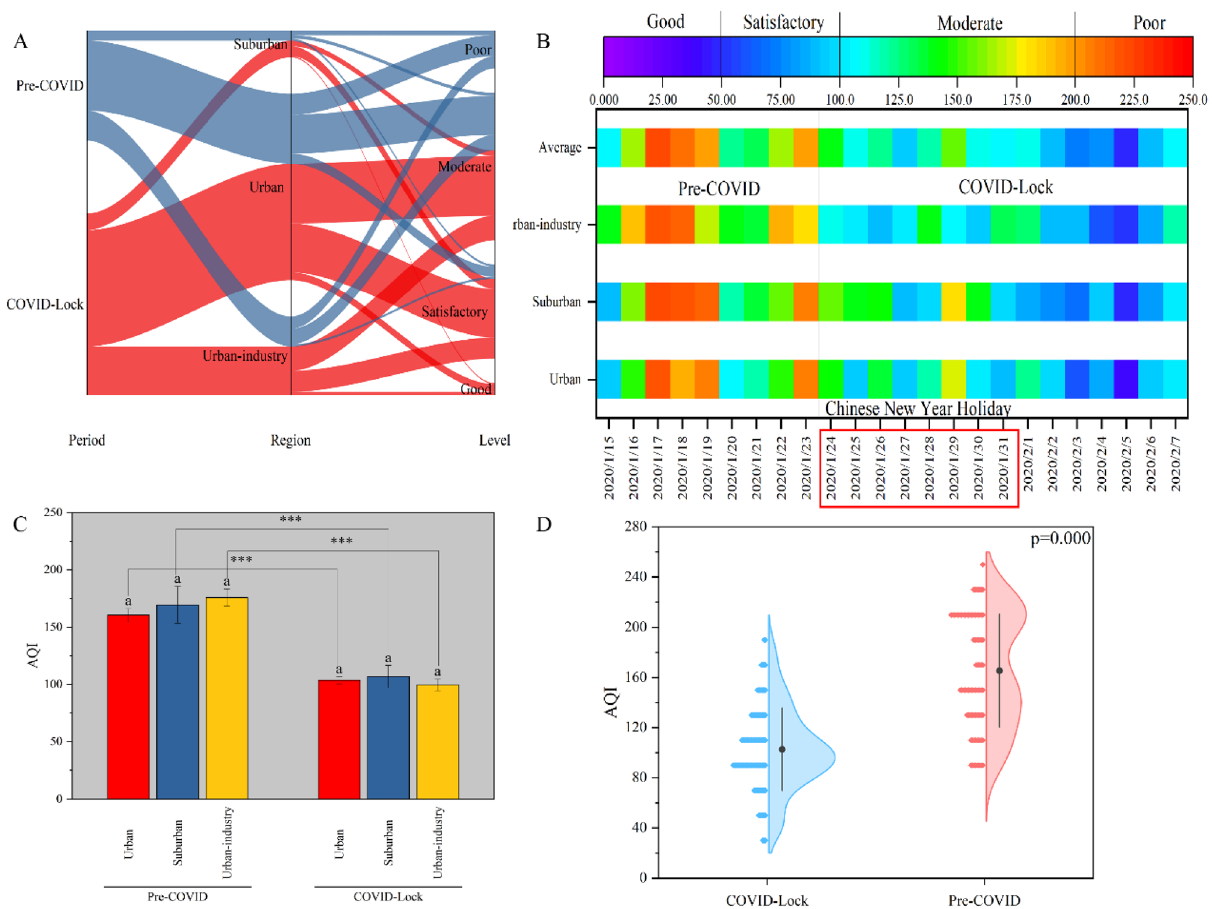
Figure 6. AQI values determined from data collected at the Ji’nan monitoring stations from 15 January to 7 February. ( A ) The parallel plot shows how the AQI level differs among the urban, suburban, urban-industrial areas. ( B ) AQI values determined as time series; ( C ) comparison of the AQI levels among different regions during the pre-COVID and lockdown period; ( D ) comparison of AQI between the pre-COVID and lockdown periods.